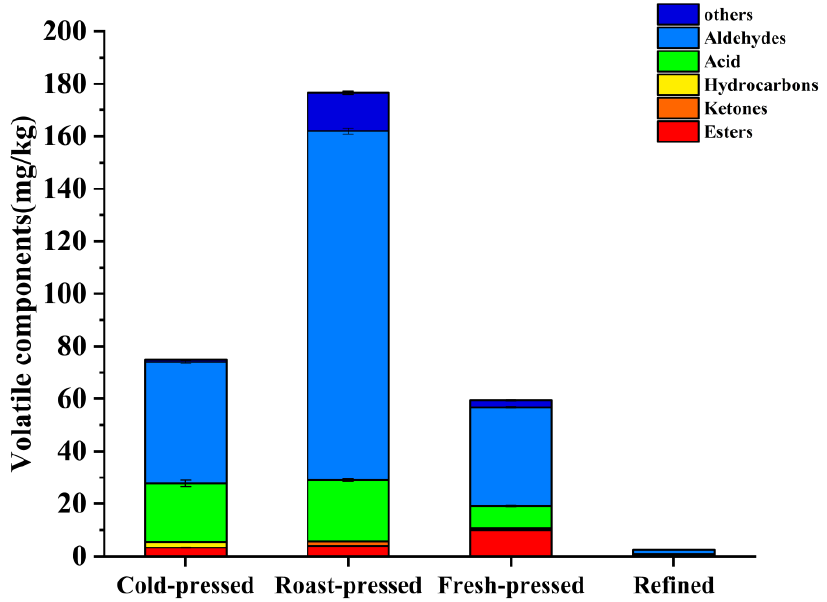
Figure 4. Classification of volatile compounds in camellia oil with different processing techniques.